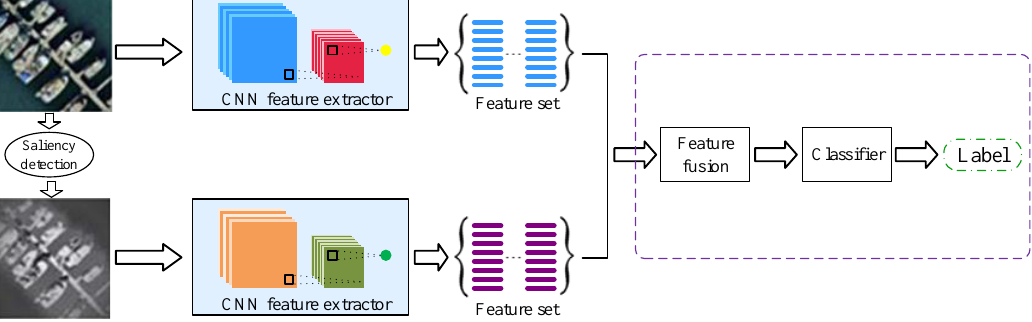
Figure 4. The saliency coded two-stream deep architecture. The raw RGB network stream takes RGB images as input. The saliency coded network stream takes the processed images through saliency detection as input. Two different sets of features are fused using the two-stream deep feature fusion model.